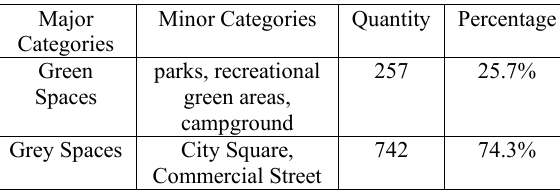
Tabel 1 . Number and proportion of green space and gray space POIs in the central city of Wuhan.